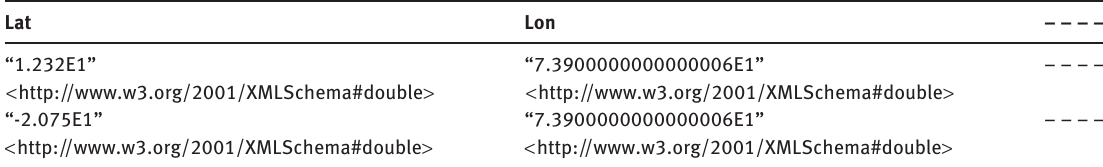
Figure 6: Semantic Query Execution and Visualization. Table 1: Sample Results of SPARQL Query Represents Latitude and